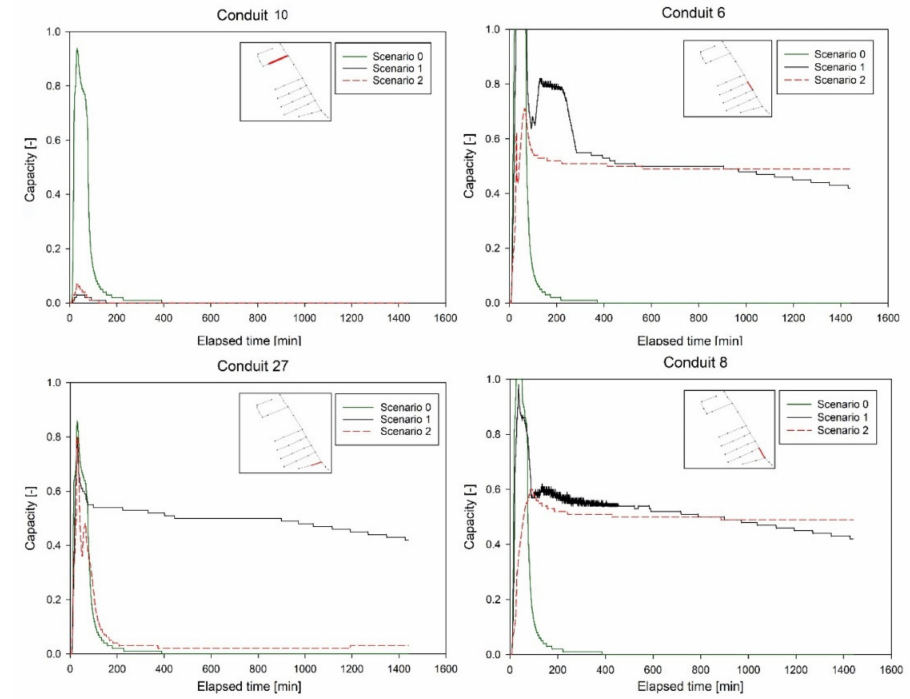
Figure 5. The drainage network response, in terms of conduits capacity over the time, to the design storm event (RP = 10 years) for each modeled